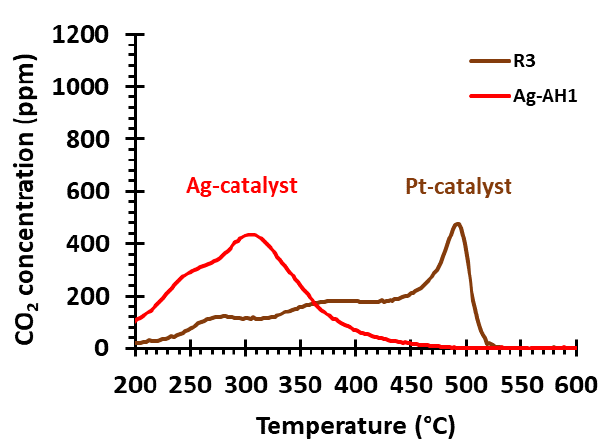
Figure 4. Performance of the Ag-AH1 and R3 catalysts. For more details about the catalysts, see Table